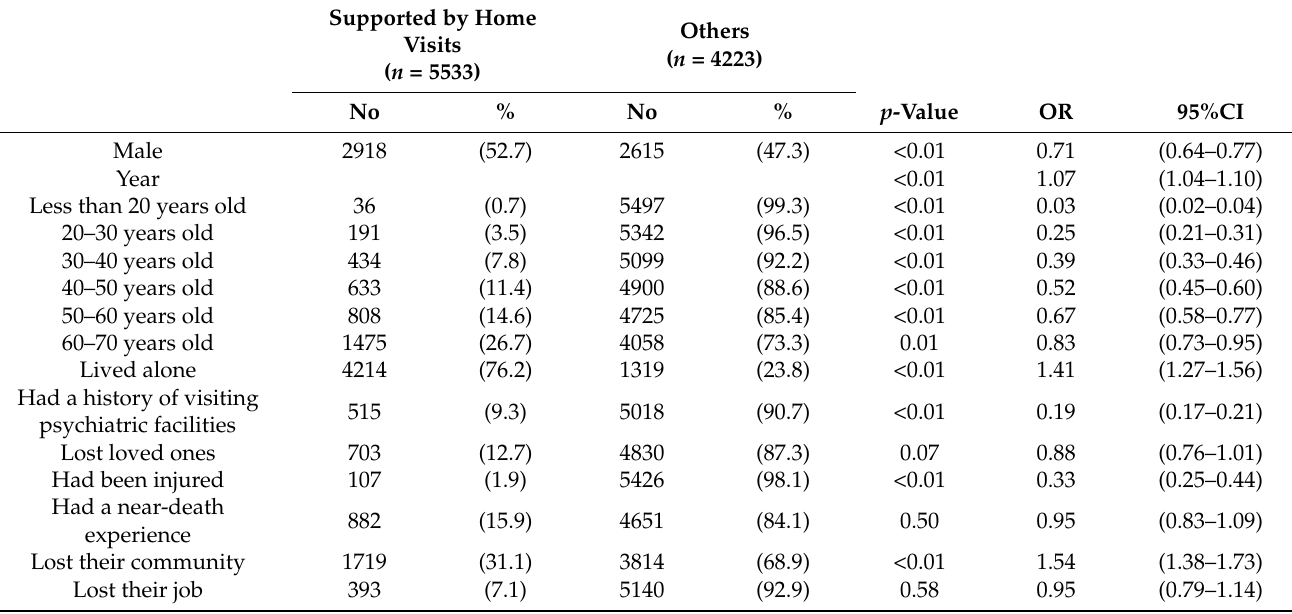
Table 3. Factors related to the residents who were supported by home visits through the